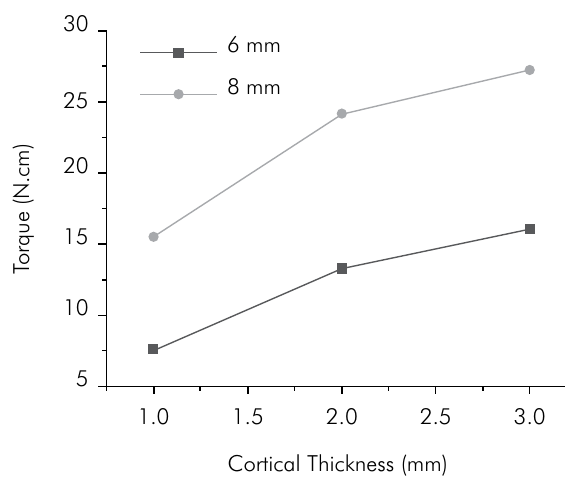
Figure 4. Variance in insertion torque values for 6- and 8-mm MIs inserted in cortical bone of different